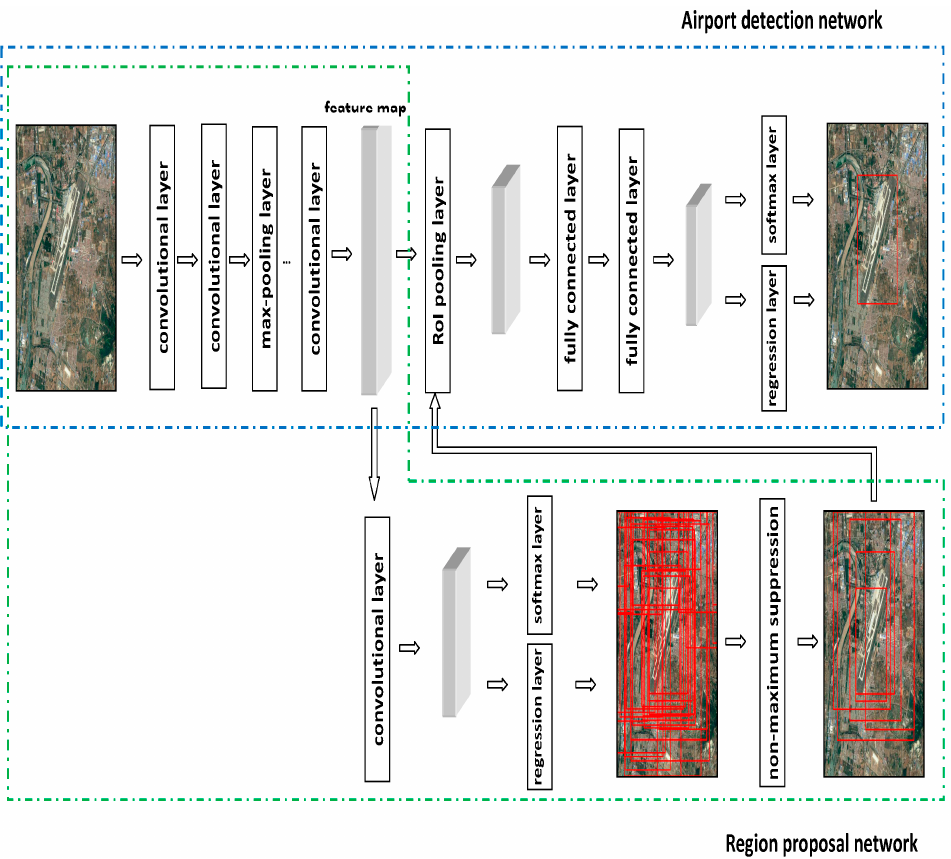
Figure 1. The airport detection network architecture is shown in the blue frame, and the region proposal network architecture is shown in the green frame.